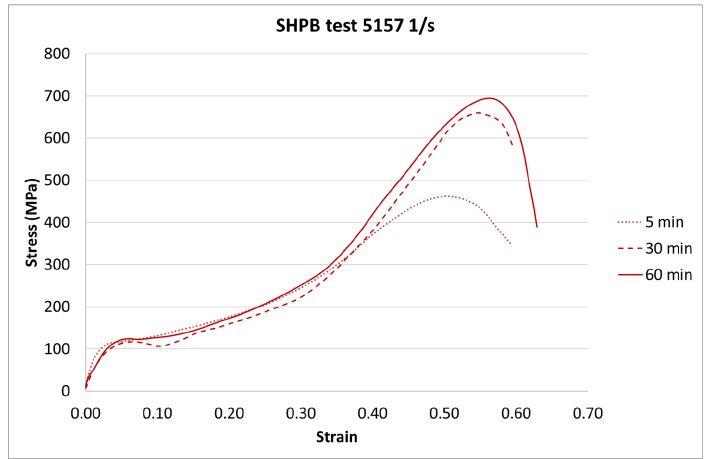
Figure 13. Results of the Split Hopkinson’s Pressure Bar (SHPB) test (strain rate of 4317 1/s) of durable resin for curing times of 5, 30, and 60 min for ultraviolet (UV) and heat exposure.